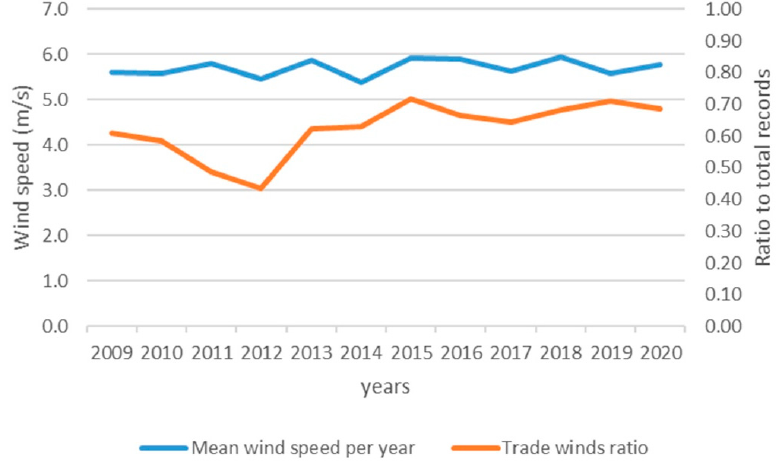
Figure 4. Average values of the wind records taken by the buoy over the year (2009–2020 period).